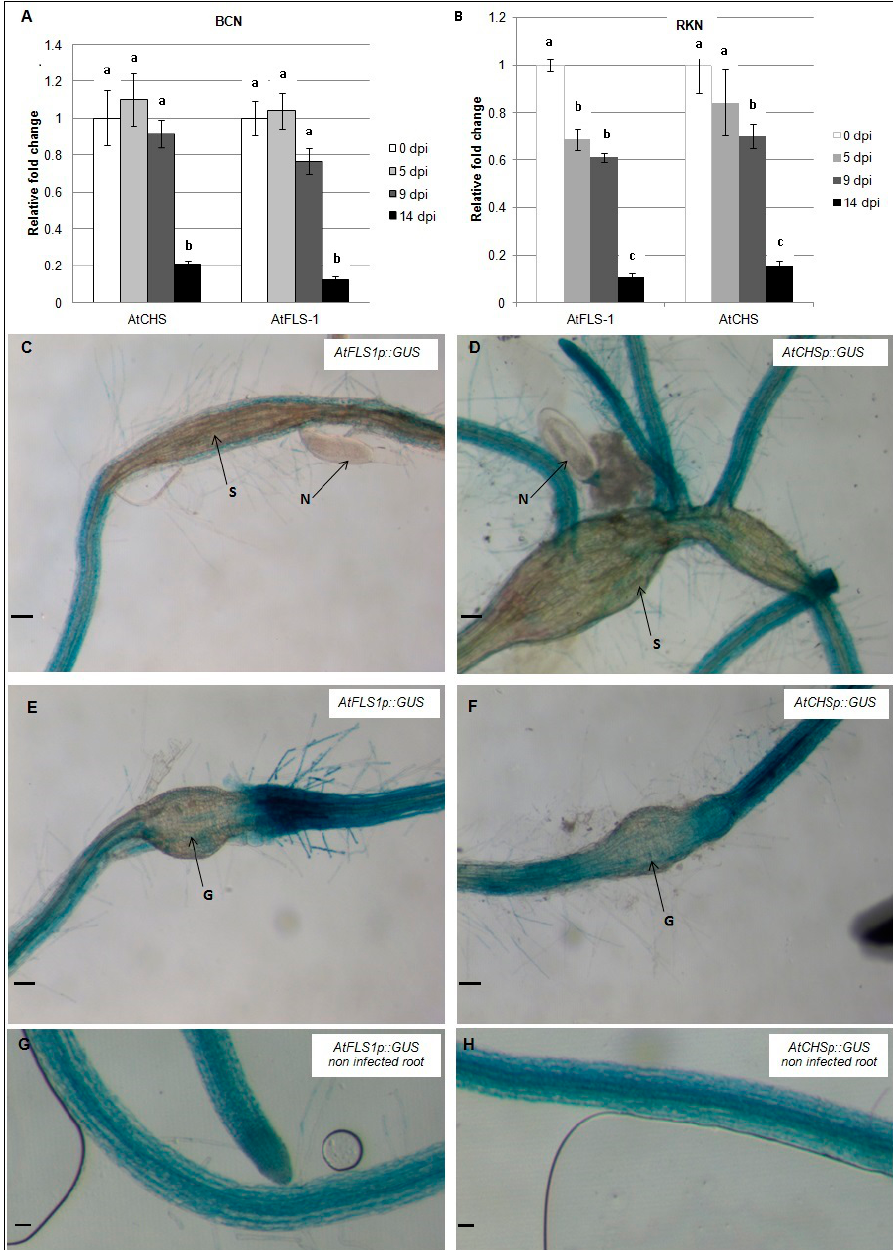
Figure 3. Temporal patterns of AtCHS and AtFLS1 gene expression during nematode infection. AtCHS and AtFLS1 gene expression was quantified by qRT-PCR in roots of wild-type Arabidopsis plants at 0, 5, 9 and 14 days post-infection (dpi) with the sugar beet cyst nematode, H. schachtii ( A ) or the southern root-knot nematode M. incognita ( B ). Histochemical localization of GUS activity directed by AtCHSp::GUS and AtFLS1p::GUS fusion in H. schachtii- induced syncytia ( C , D ) and in M. incognita -induced gall ( E , F ) at 9 dpi and in non-infected controls ( G , H ). G, gall; N, nematode; S, syncytium; R, Arabidopsis root . Expression was normalized to the Arabidopsis Actin8 gene and presented relative to expression at 0 dpi. Values are means ± SE (3 technical replicates) with different letters indicating significant differences between time points p < 0.05 (One-way ANOVA test). Similar results were obtained from a second, independent biological replicate. Scale bar = 200 μ m ( C , D , G , H ), and 100 μ m ( E , F ).